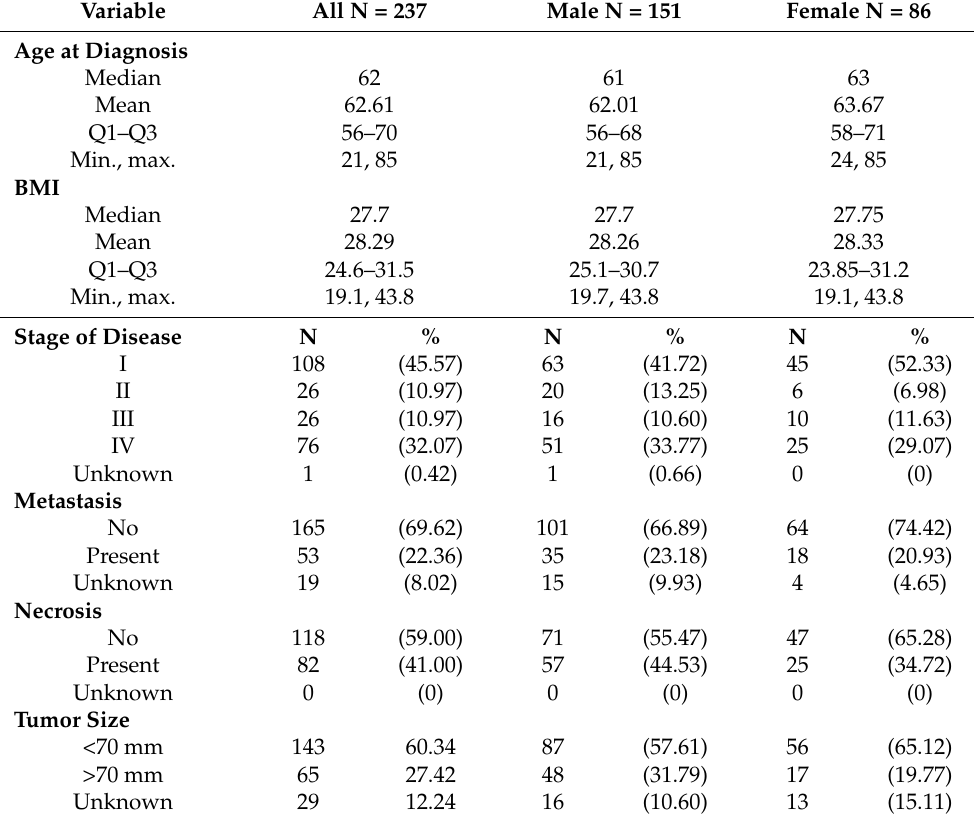
Table 6. Characteristics of the ccRCC